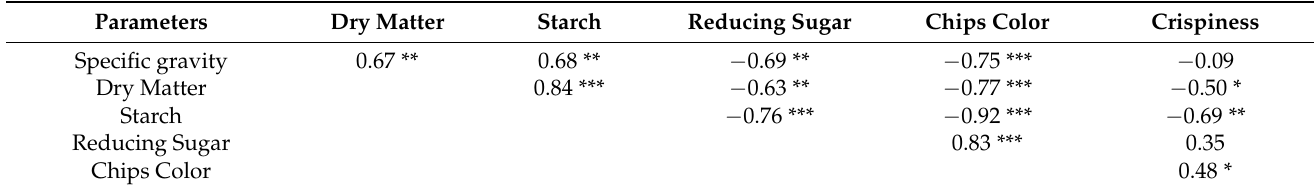
Table 6. Correlation studies among specific gravity, dry matter, starch, reducing sugar, chip color, and crispiness of potato